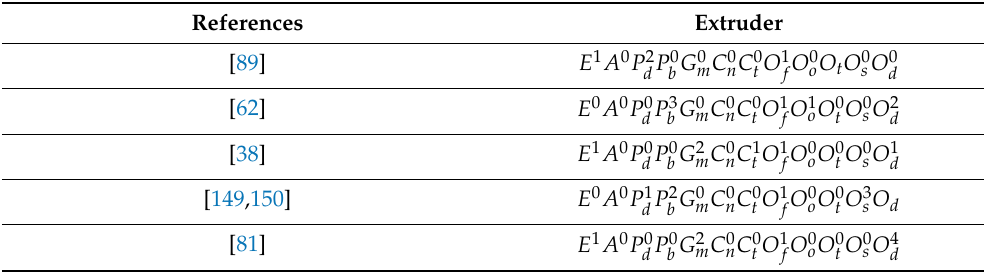
Table 11. Some examples of E3DCP technologies based on this classification